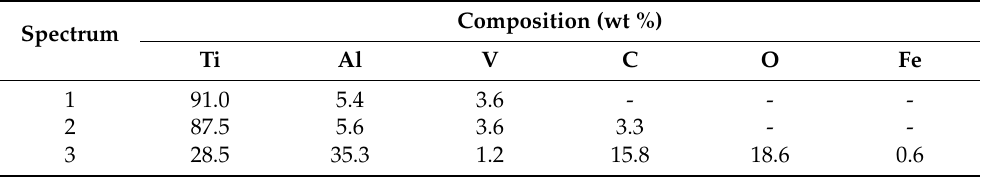
Table 4. EDX analysis results of the Ti/Al IMC layer from sample